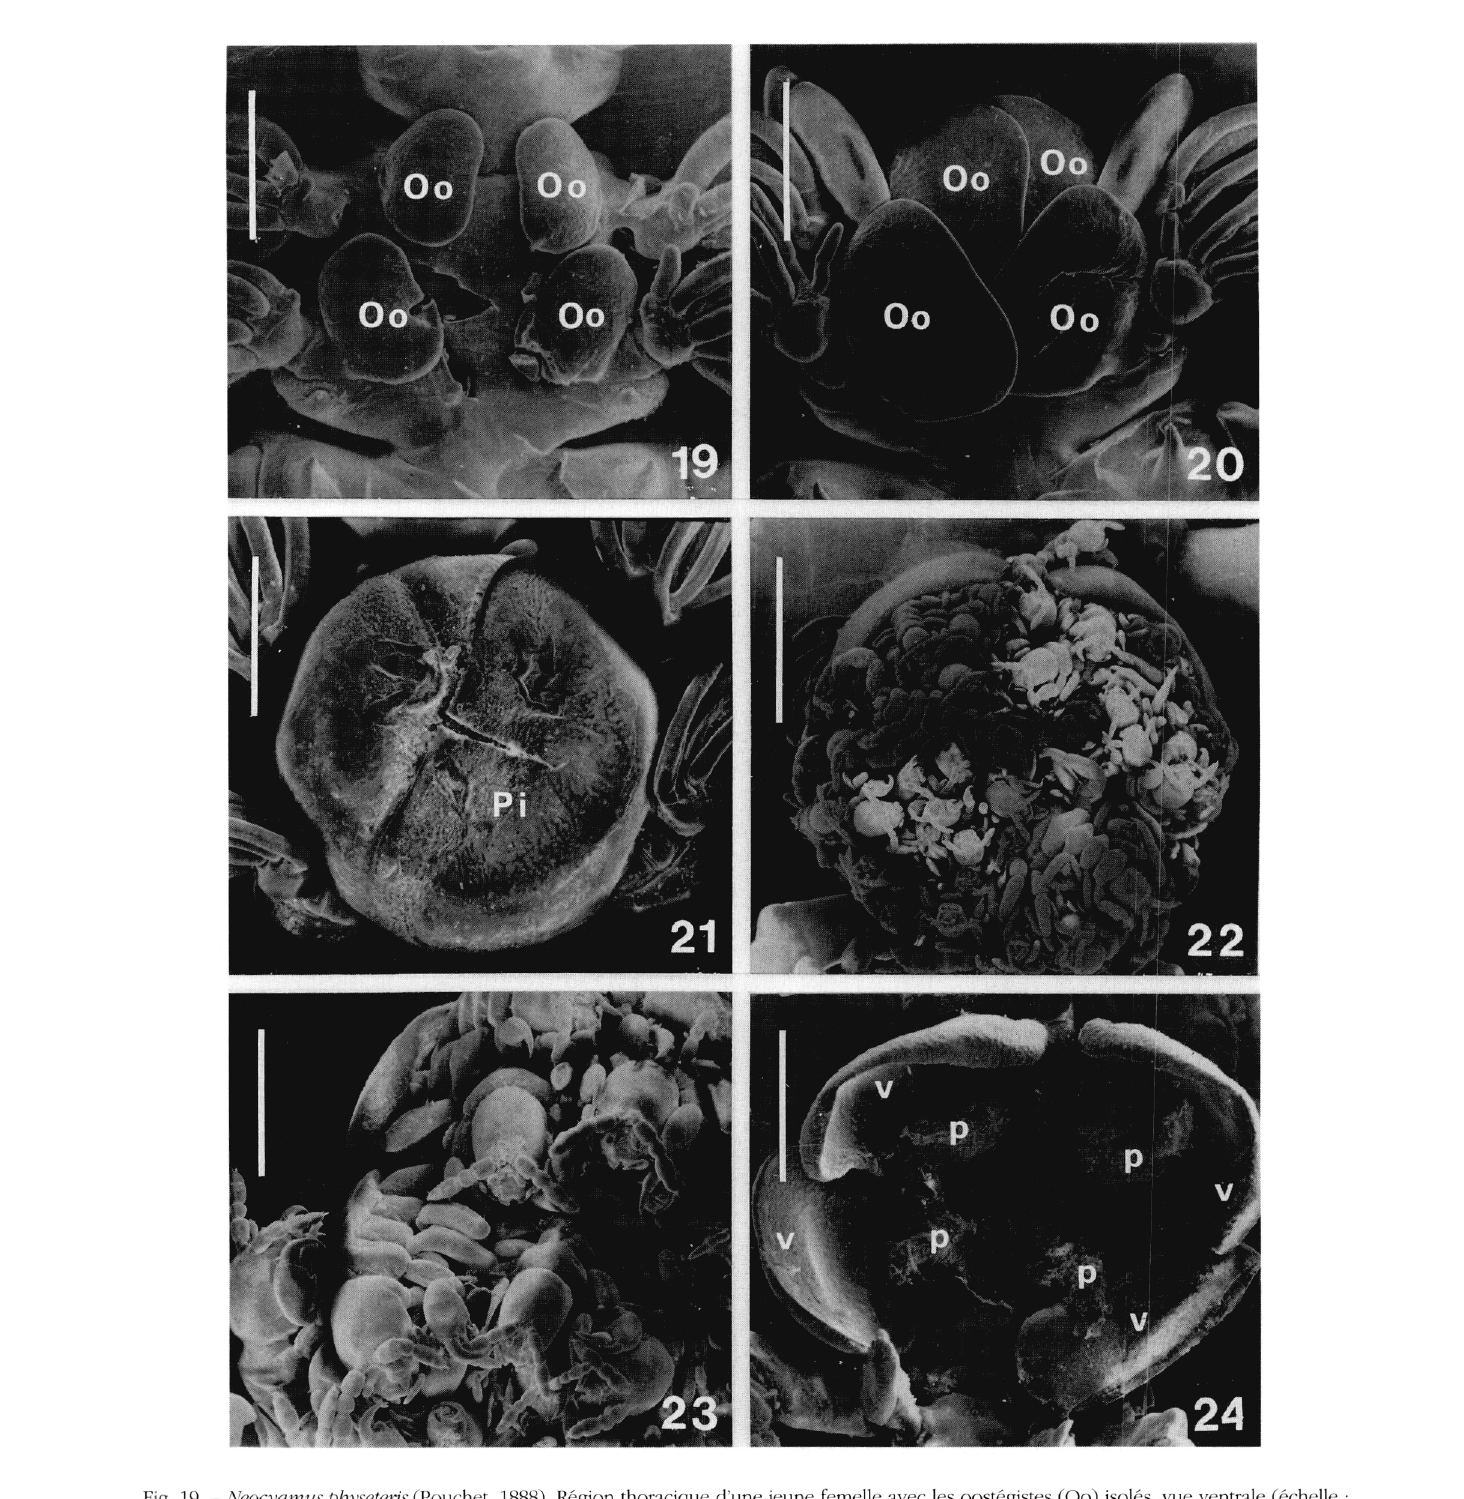
Fig. 19. - Neocyamus physeteris (Pouchet, 1888). Région thoracique d’une jeune femelle avec les oostégistes (Oo) isolés, vue ventrale (échelle : 600 μm). Fig. 20. - Neocyamus physeteris (Pouchet, 1888). Région thoracique d’une femelle fécondée avec les oostégites (Oo) recouvrants, vue ven­ trale (échelle : 800 μm). Fig. 21. - Neocyamus physeteris (Pouchet, 1888). Région thoracique d’une femelle gestante avec la poche incubatrice (Pi) développée, vue ventrale (échelle : 800 μm). Fig. 22. - Neocyamus physeteris (Pouchet, 1888). Poche incubatrice avec des pulii (échelle : 1500 μm). Fig. 23. - Neocyamus physeteris (Pouchet, 1888). Détail de la poche incubatrice avec des pulii (échelle : 600 μm). Fig. 24. - Neocyamus physeteris (Pouchet, 1888). Poche incubatrice vide après le départ des pulii, p : “placentas”, v : valves de la poche incubatrice (échelle : 1200